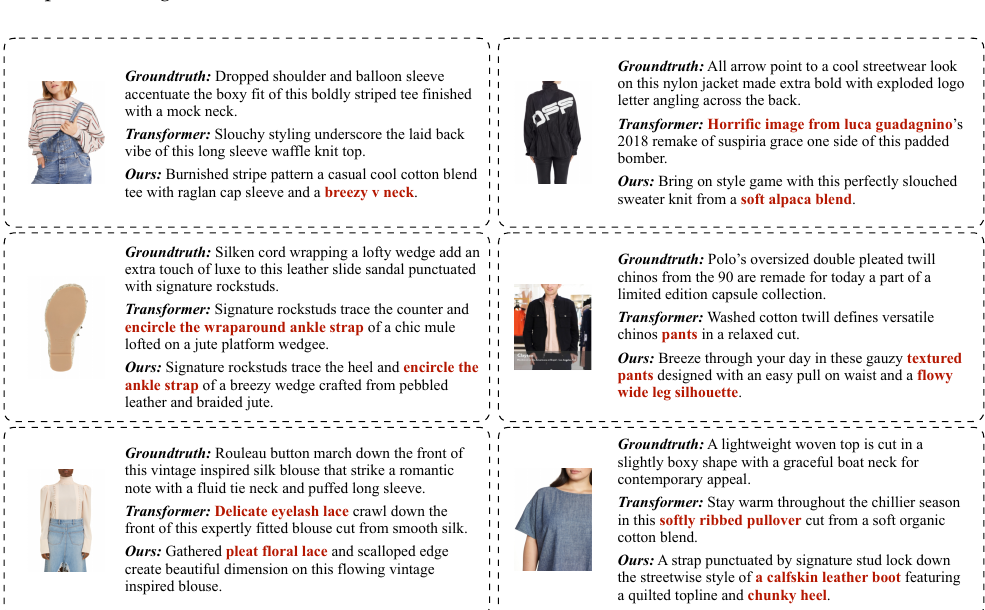
Figure 3. Qualitative results of the proposed approach with and without the retrieval strategy, compared with ground-truth sentences.